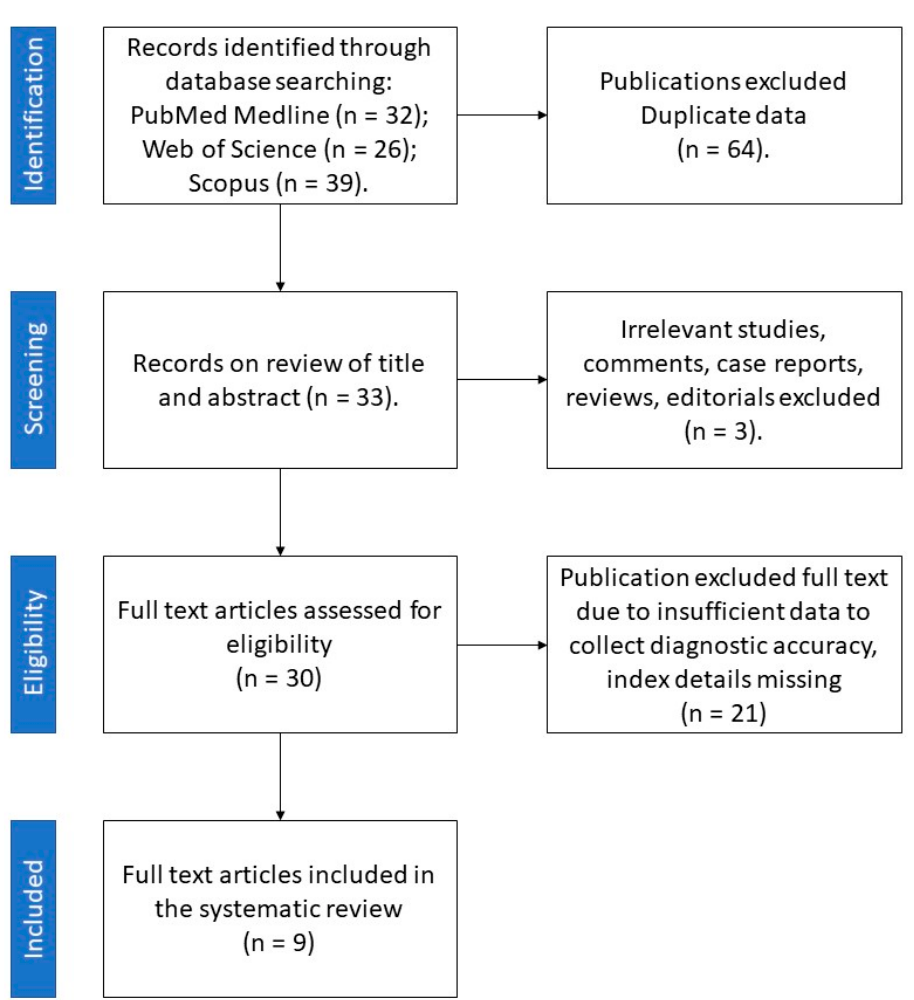
Figure 3. Retrieval flowchart to obtain study data for systematic